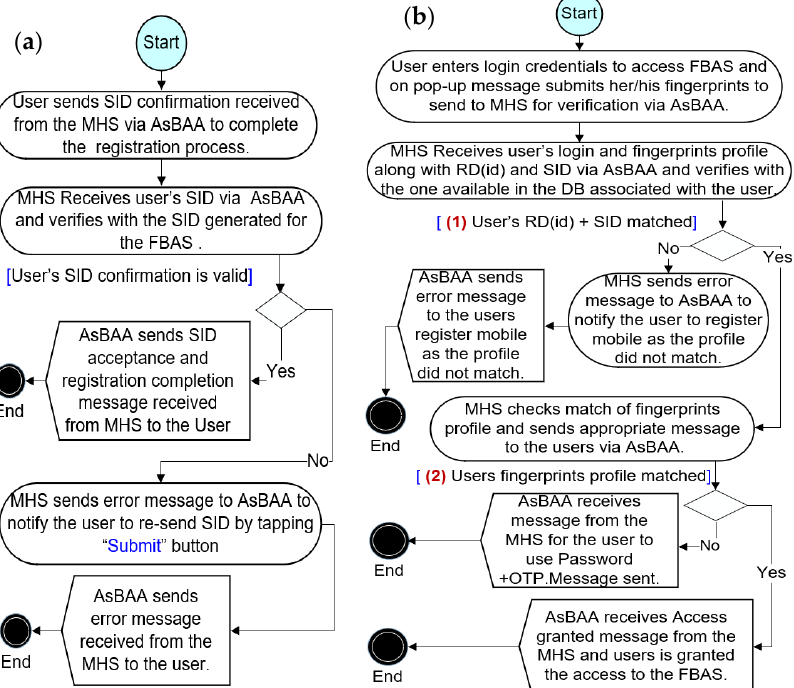
Figure 4. ( a ) Shows the process flow of SID confirmation and registration completion. ( b ) Shows the authentication process flow steps after registration completion in the Bio-Guard app.